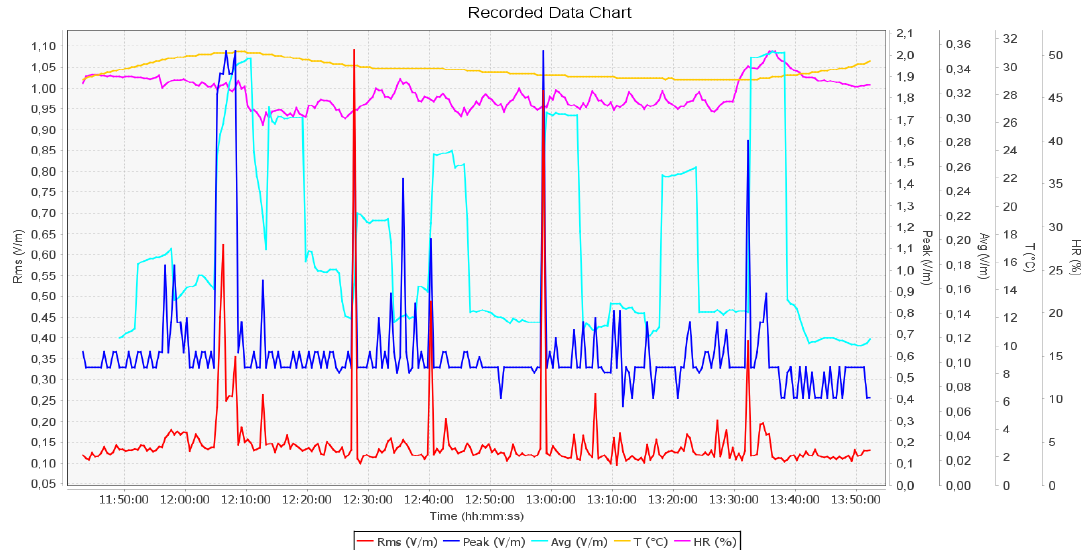
Figure 4. The intensity of the electrical component of the electromagnetic field in the course of flight no. 2 for the Aero AT3.